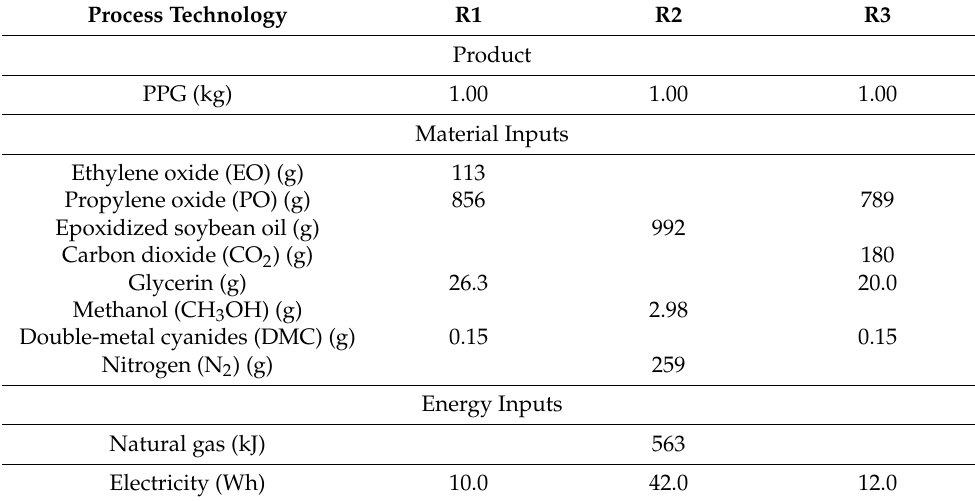
Table 1. The main material and energy inputs used in PPG synthesis in conventional (applying DMC as catalyst), vegetable, and CO 2 -based